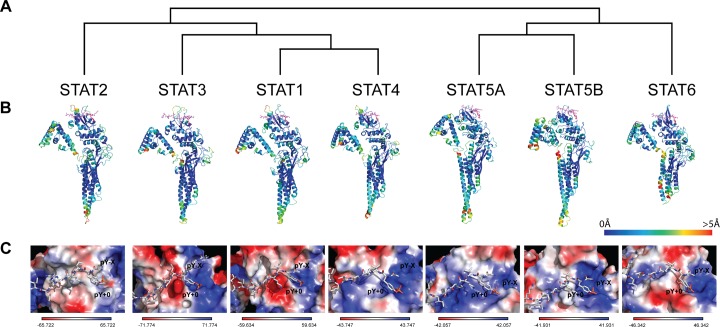
Structural models and phylogenetic comparison of hSTAT monomers (1, 2, 3, 4, 5A, 5B and 6) with their specific pTyr-linkers.
(A) Phylogenetic distribution of hSTATs in form of a simplified phylogenetic tree. (B) Models of the monomers are shown in the cartoon representation with pTyr-peptides in the stick representation. Specific domains are positioned as follows: N-domain on the top-left, coiled-coiled domain on the bottom-center, C-domain on the top-right and SH2 domain on the top-center, to facilitate visual analysis of phosphotyrosine (pTyr)-linker and the SH2 interactions. Monomers are colored according to the predicted local deviation from the real structure (the predicted error of the model), as calculated by MetaMQAP. Blue indicates low predicted deviation of Cα atoms down to 0Å, red indicates unreliable regions with deviation > 5Å, green to orange indicate intermediate values. pTyr-peptides are colored in violet, while pTyr residue is colored in pink. (C) Models of hSTAT dimers with the linker of monomer I in the SH2 domain of monomer II. pTyr-peptides are presented in stick representation, pY+0—pTyr binding pocket, pY-X—hydrophobic side-pocket. SH2 domains are in the surface representation, colored according to the distribution of the electrostatic surface potential, calculated with APBS. Blue indicates positively charged regions, red indicates negatively charged regions.